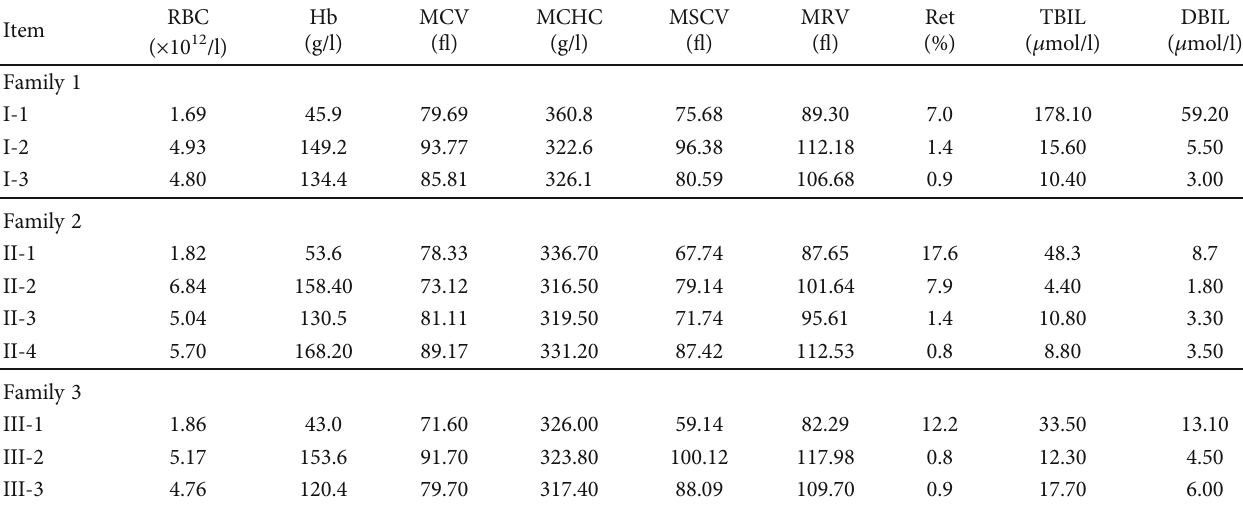
Table 1: Laboratory characteristics of probands and their families.